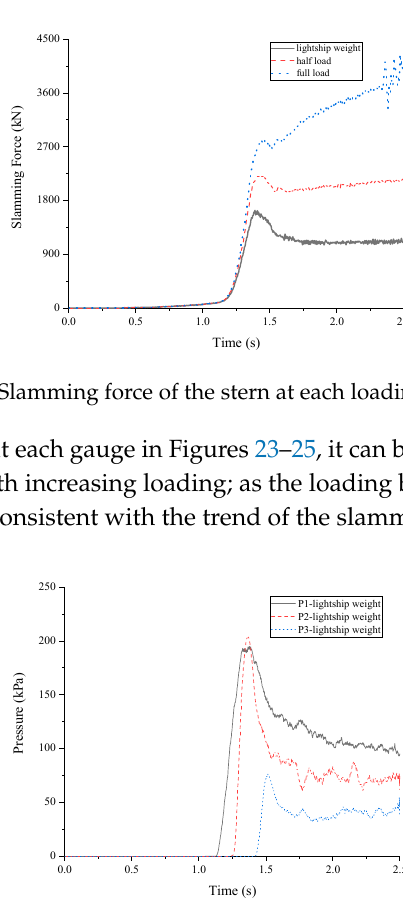
Figure 24. Pressure at P1, P2 and P3 at half load.